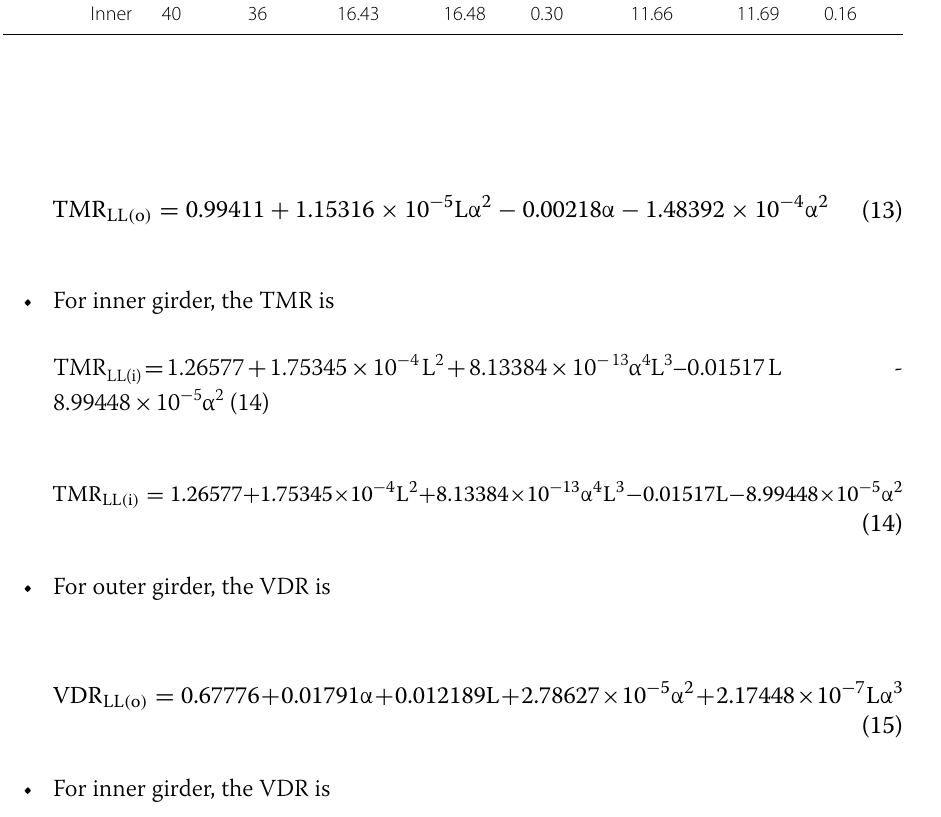
Table 3 Verification of the proposed equation Forces Girder Span BM